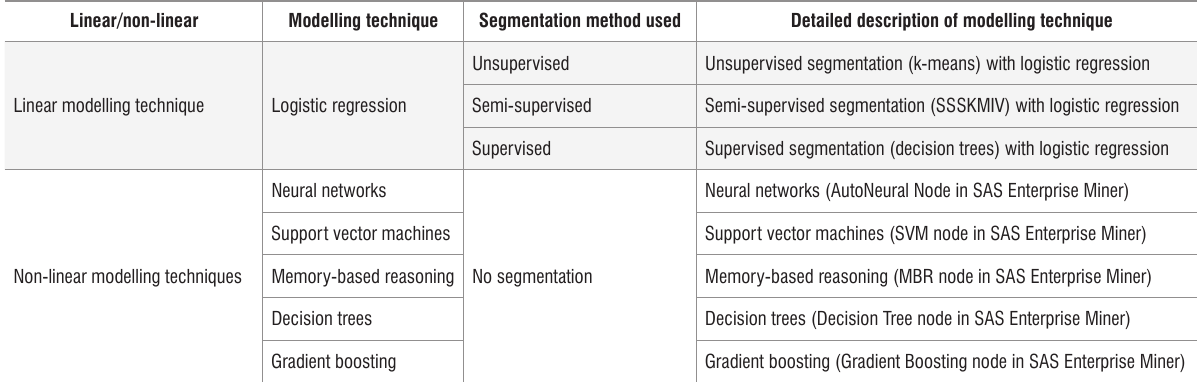
Eight modelling techniques Linear/non-linear